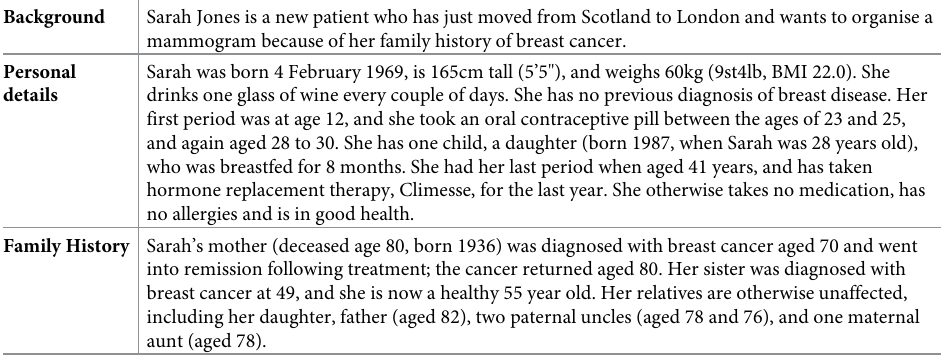
Table 2. Example vignette based case used in France and Germany.